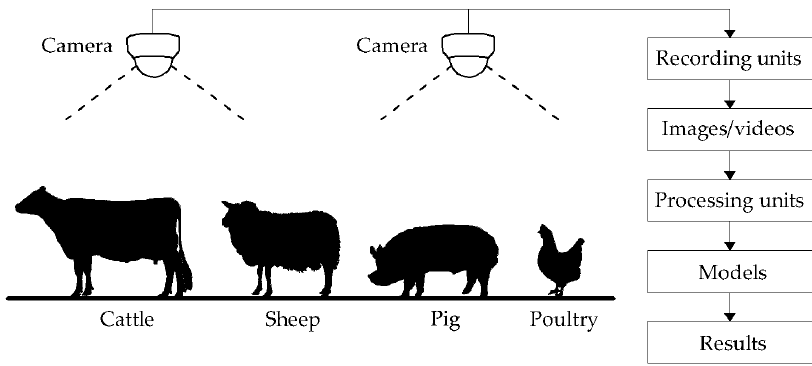
Figure 1. Schematic drawing of a computer vision system for monitoring animals.